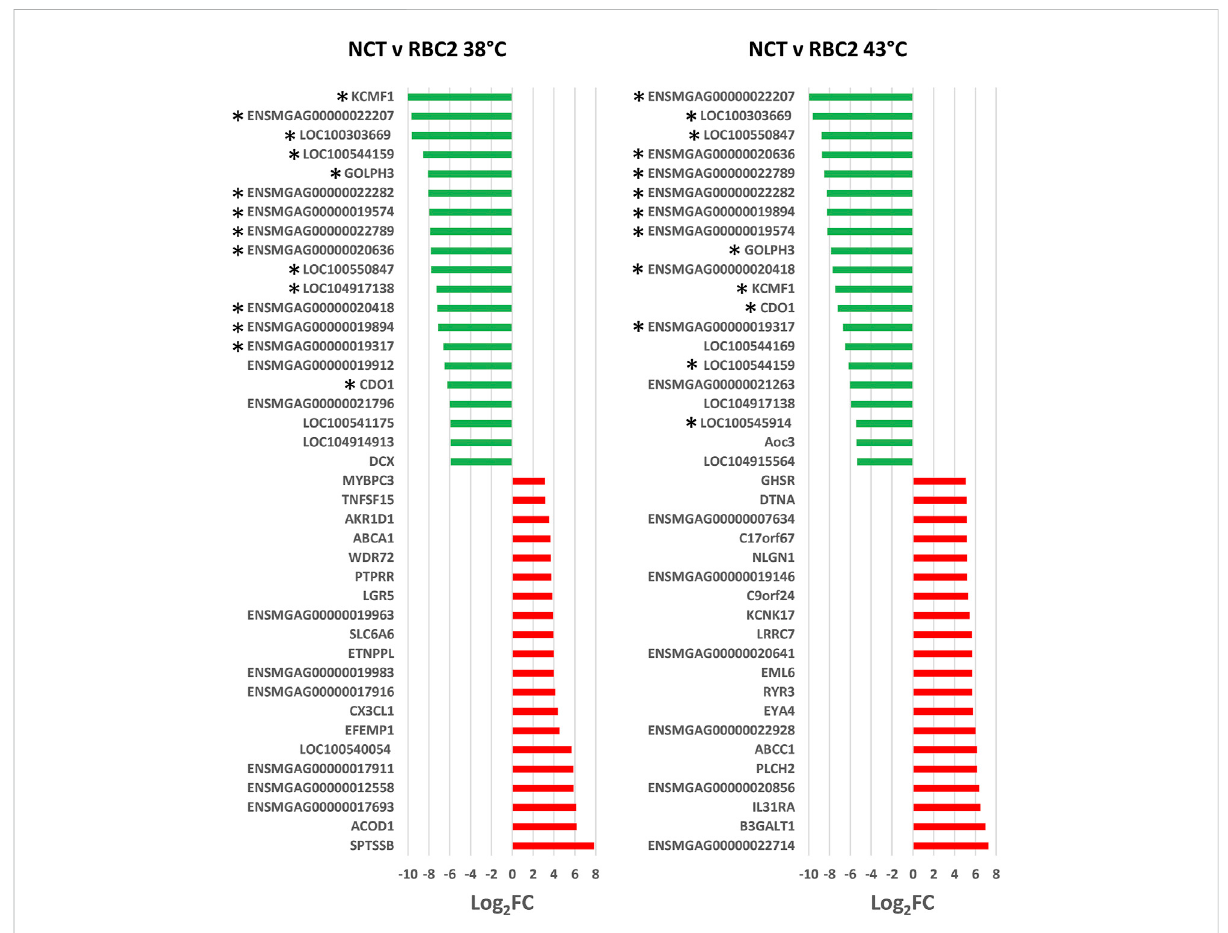
FIGURE 5 Directional change in the genes showing the highest expression differences at 43 ° C compared to 38 ° C. For each with-in line comparison (RBC2 and NCT) the Log 2 FC for each gene is plotted (FDR pval < 0.05). Genes shared between temperatures are indicated by asterisks.